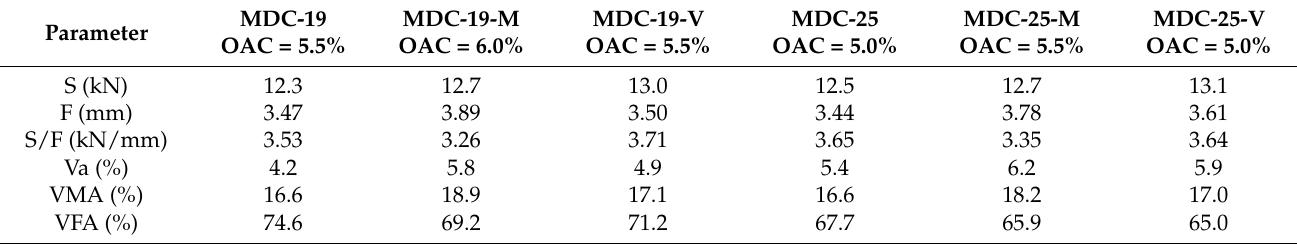
Figure 3. Marshall test results of MDC-19, MDC-19-M, and MDC-19-V: ( a ) Va content; ( b ) VFA content; ( c ) stability—S; ( d ) S/F ratio. Table 4. Values of Marshall test results in